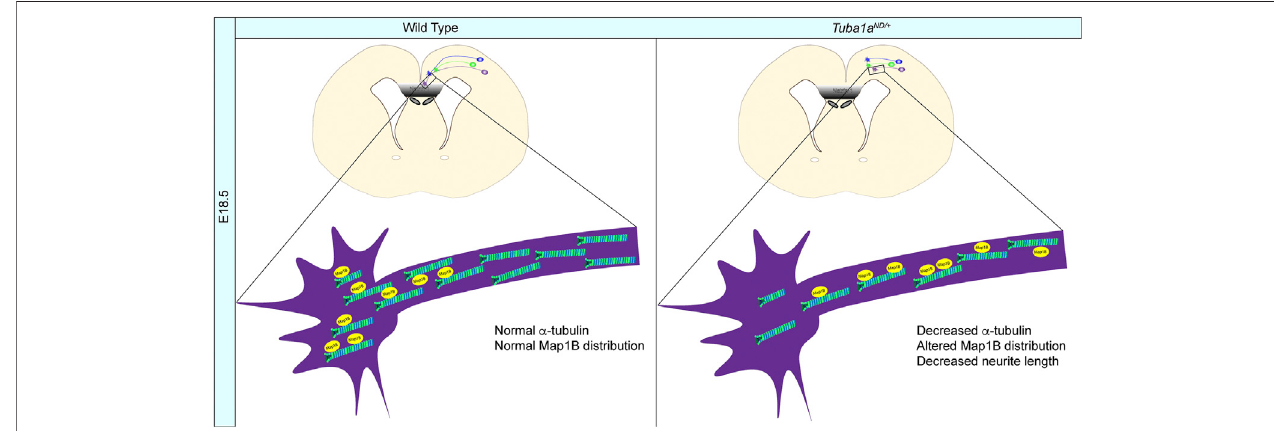
FIGURE 8 | Mechanisms of Tuba1a-induced axonal path fi nding de fi cits. (A) Schematic illustrating how reduced Tuba1a may impair ability of Tuba1a ND/+ axons to reach key signaling points at the correct developmental time to support proper brain formation. Wild-type axons (WT; left) reaching the midline crossing point of corpus callosum by embryonic day (E) 18.5 are compared to the potentially stunted axonal growth in Tuba1a ND/+ brains (right). The reduced density of microtubules impair localization of Map1b and potentially other MAPs to contribute to slower growth of developing Tuba1a ND/+ commissural neurons.